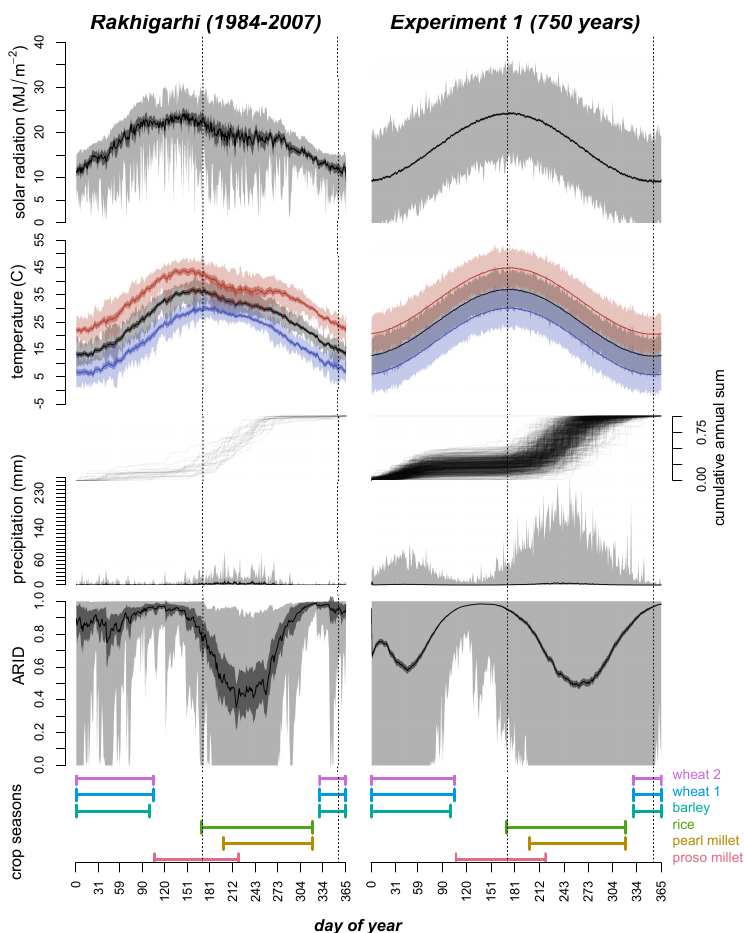
Figure 2. Summary statistics of weather variables and ARID per each day of year in (1) experiment 0, using data from Rakhigarhi, Haryana, India, between 1 January 1984 and 31 December 2007 (source: NASA POWER), and (2) experiment 1, corresponding to the simulation of 750 years (365 days). Means are solid lines, 95% Student’s t-confidence interval are dark areas, and ranges between maximum and minimum are lighter areas. The growing seasons of the crops selected are plotted in relation to both